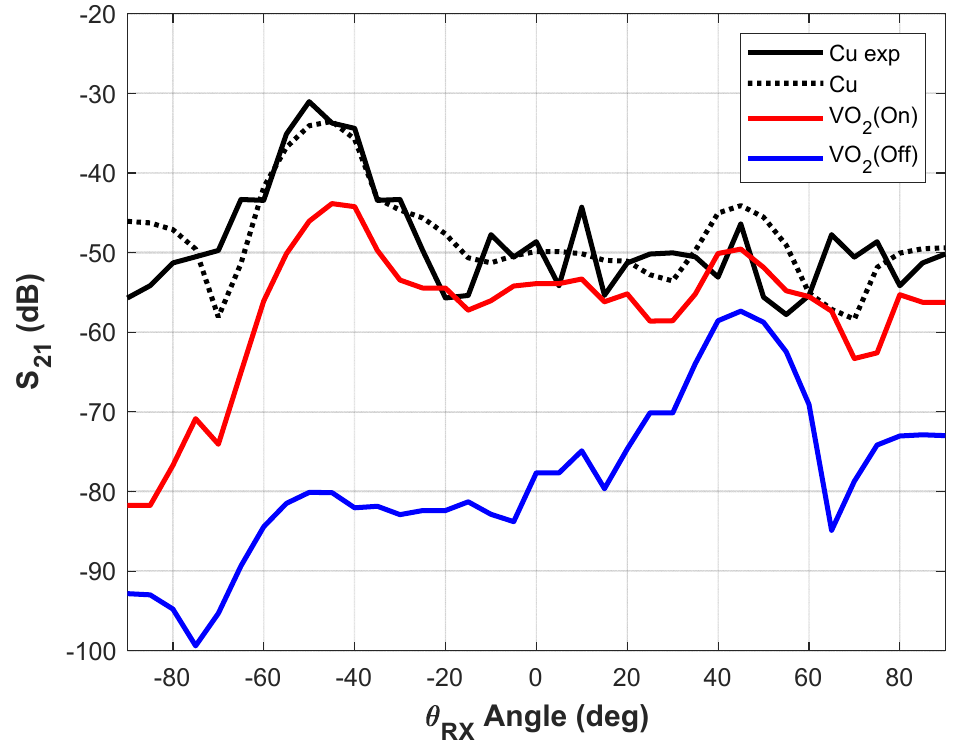
Figure 16. Graph of the bistatic RCS responses of the manufactured and evaluated FSS reflectors with fixed Tx at − 45°.